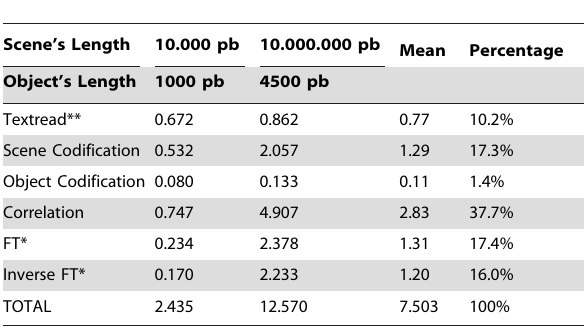
Table 4. Time (seconds) used by the main functions involved in the correlation process.